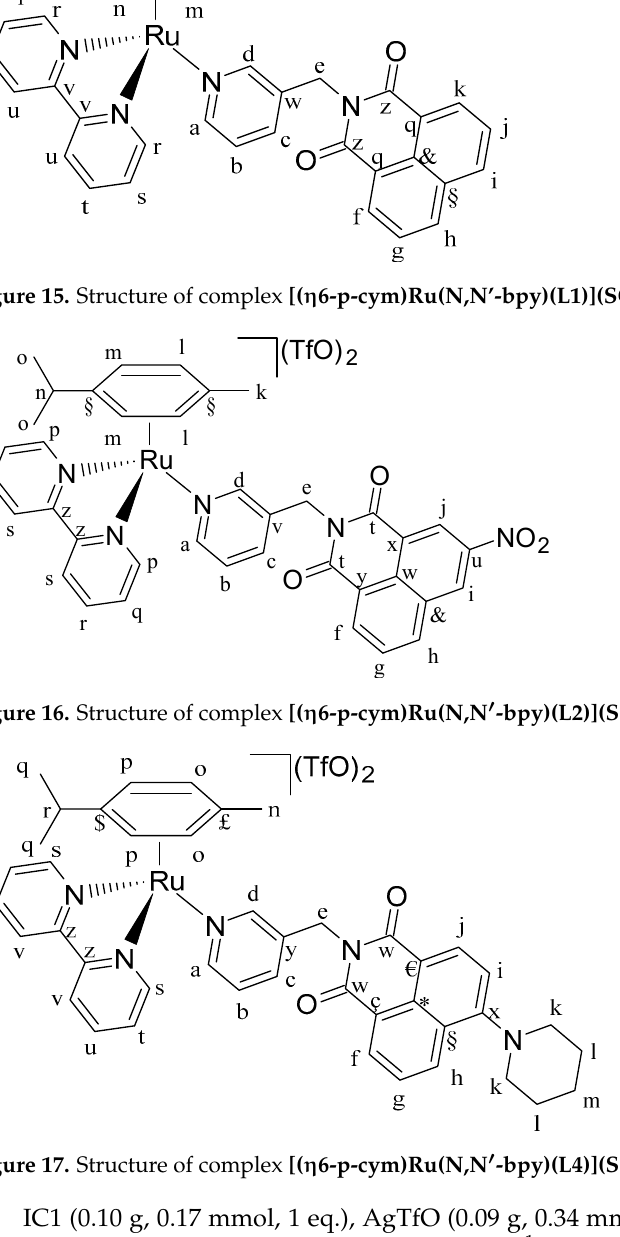
Figure 16 Structure of complex C2.